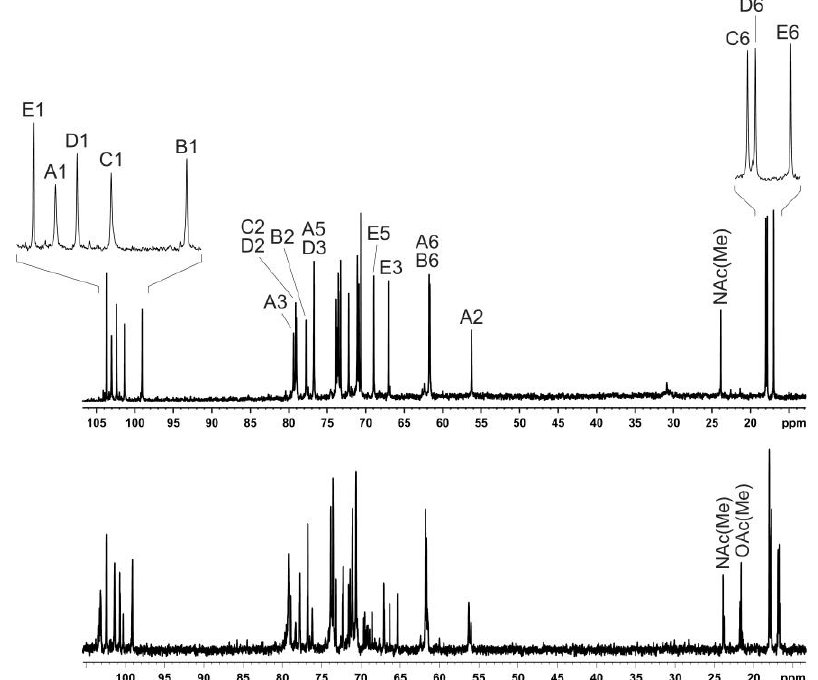
Figure 8. 13 C NMR spectra of the O-deacetylated polysaccharide (top) and O-polysaccharide (bottom). The region for CO groups is not shown. Numbers refer to carbons in sugar residue denoted by letters as indicated in Table 1 and Chart 1. E1 , E6 and E1, E6 indicate 6dTal residues that do, and do not, include the O-acetyl groups, respectively.